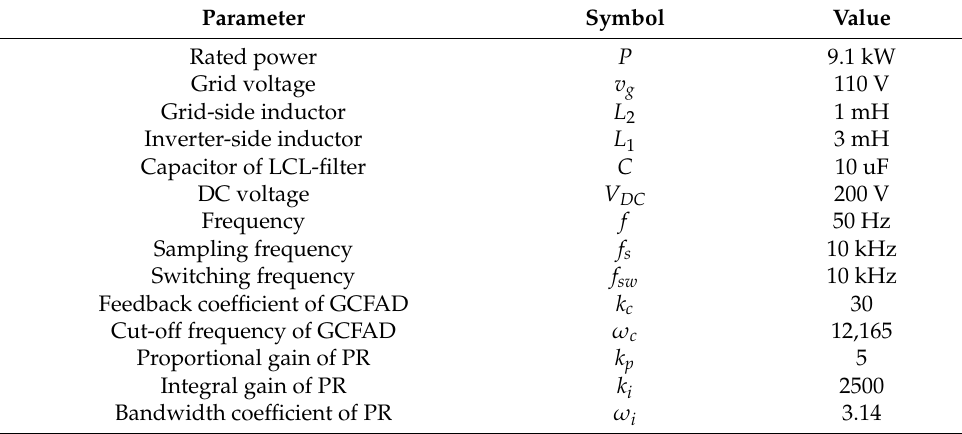
Table 1. Parameters of LCL-type inverter and